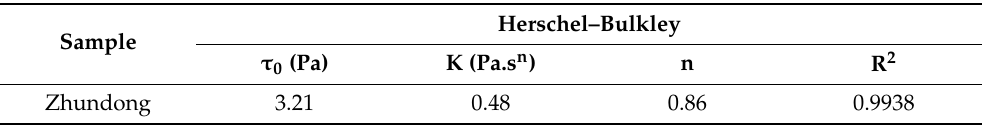
Figure 6. Relationship between shear stress and shear rate (Herschel–Bulkley model.) Table 4. Fitted parameters of CWS prepared by S-CSHE.